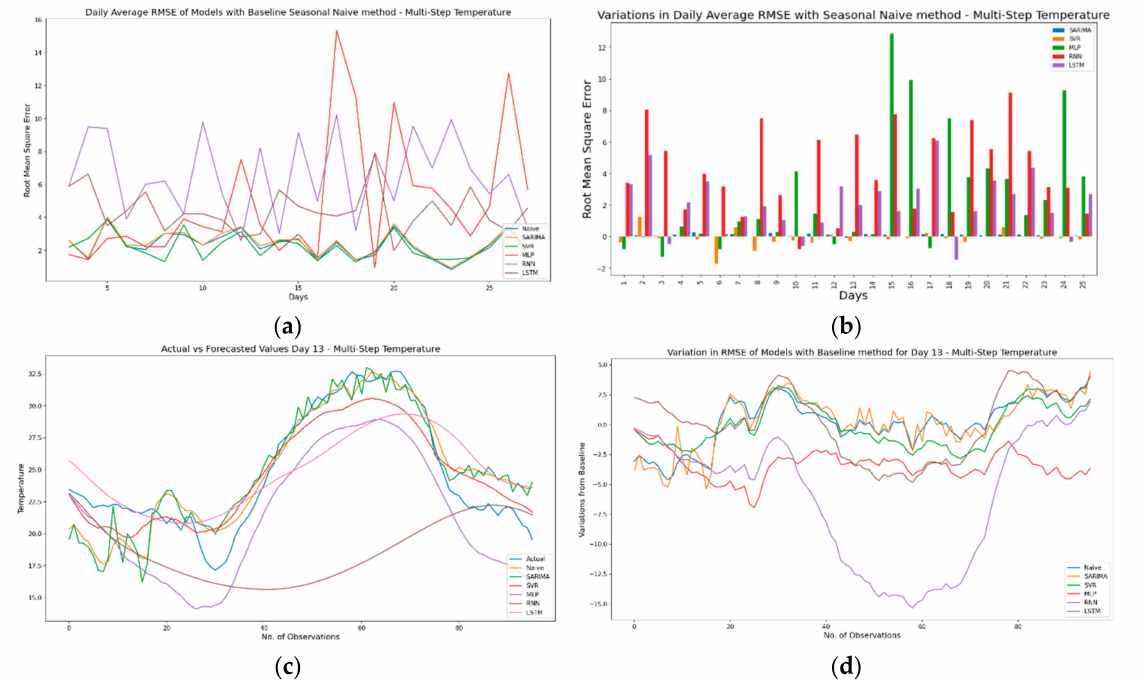
Figure 15. Comparative visualization for model performance against a baseline model—Multi-step ahead Temperature ( a ) daily average RMSE of different models with baseline seasonal naïve model ( b ) variations in daily average RMSE with performance against seasonal naïve model ( c ) combined Actual vs. Forecasts generated by different TSFAs for Day 13 ( d ) variations in RMSE of models against seasonal naïve model for Day